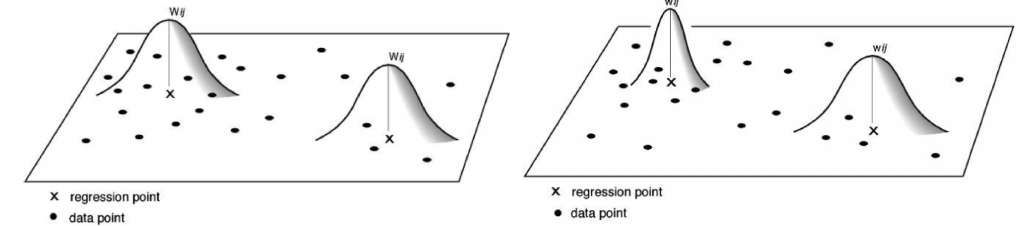
Figure 4. Reproduced from [2]. Examples of fixed ( left ) and adaptive ( right ) bandwidth